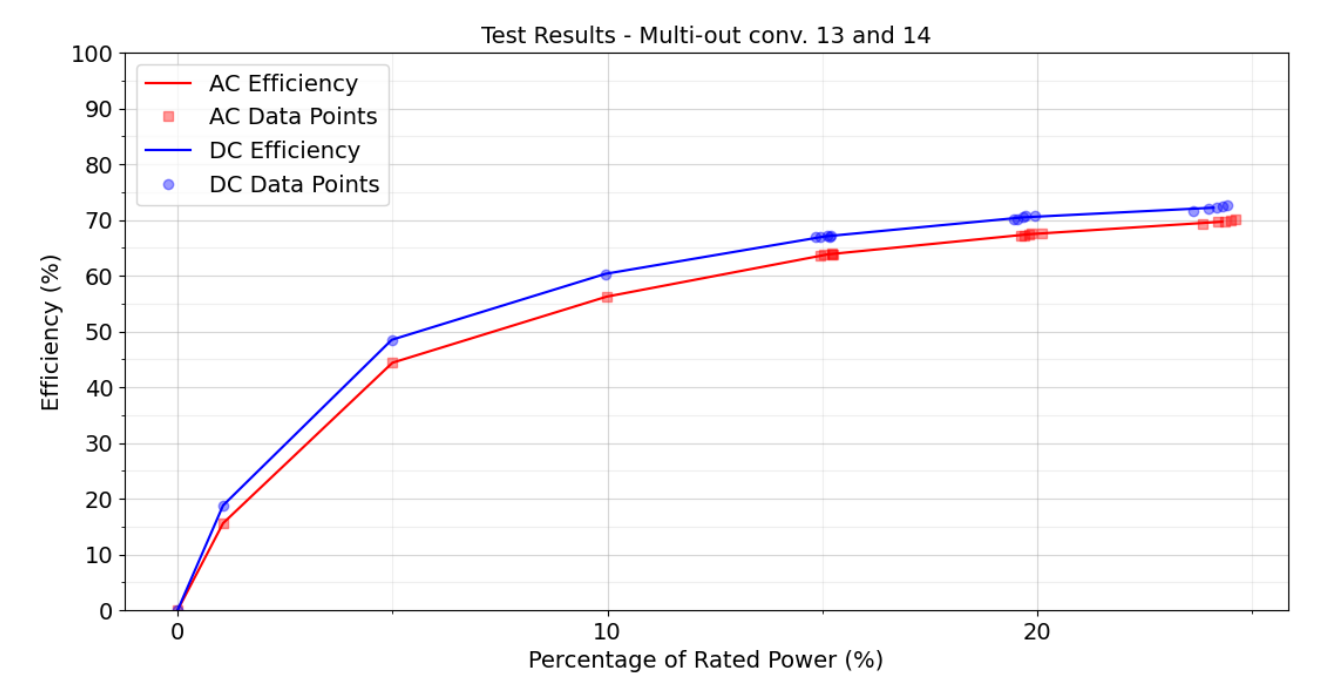
Figure 8. Efficiency curves for Converters 13 and 14. Converter 13 is model REL-185-4001-CHCO, 185 W. Converter 14 is model DC2-185-4001-CH, 185 W, tested at 24 VDC.